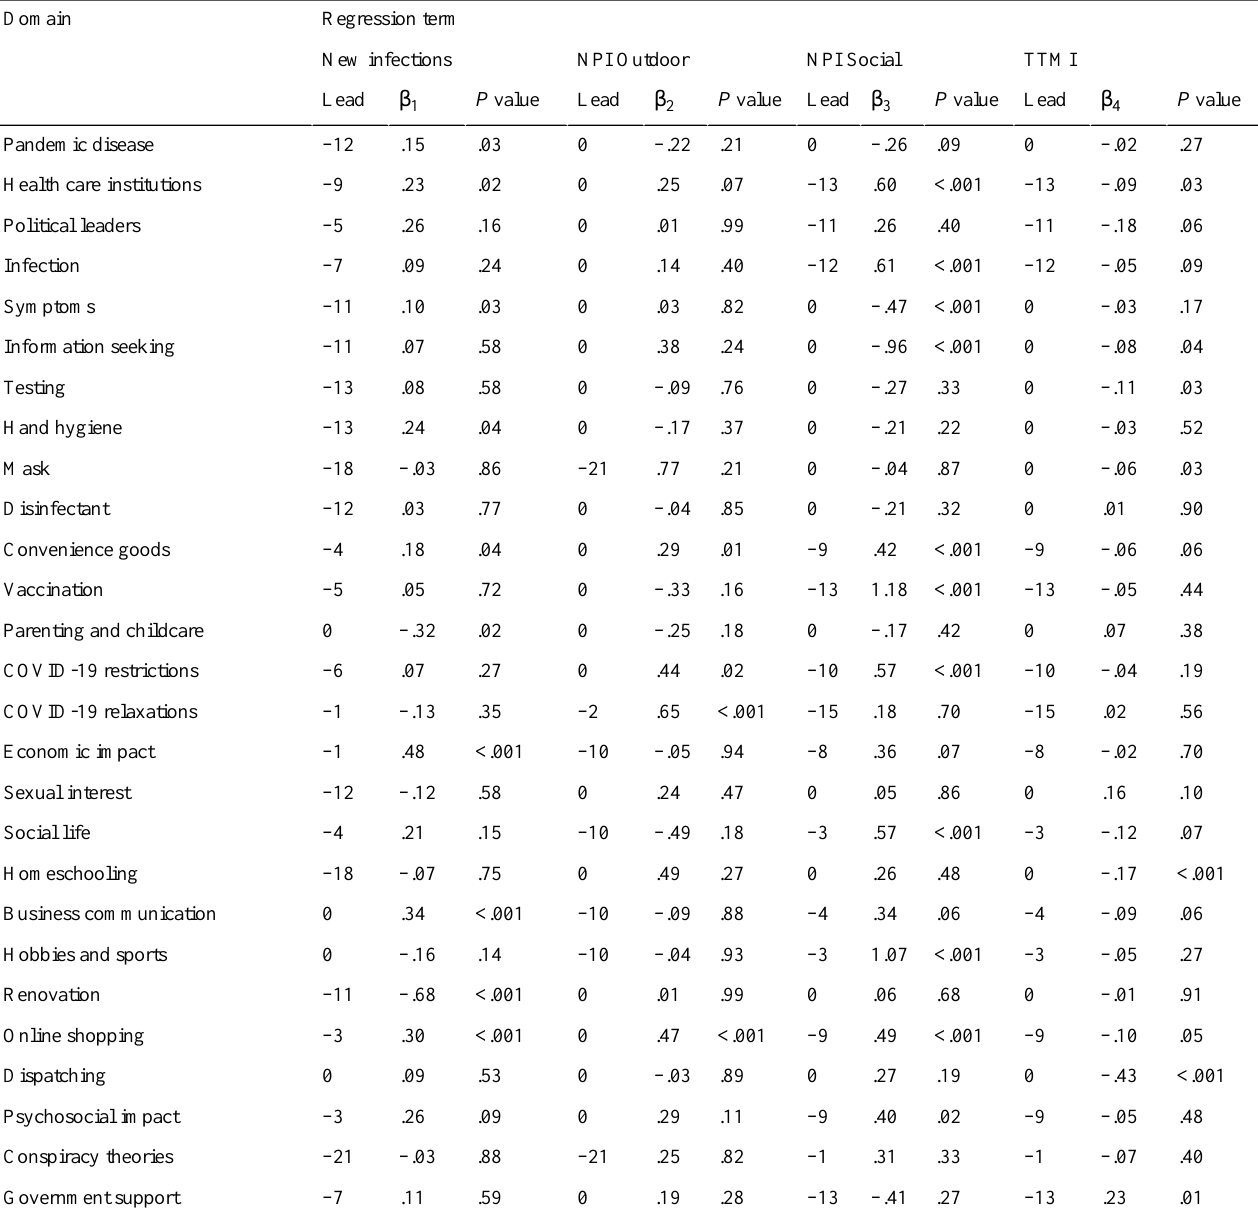
Table 3. ARIMA regression results for the regression part with standardized betas for the intercept and all relevant predictors (infection cases, both NPI factors, and the TTMI), separate for all domains a